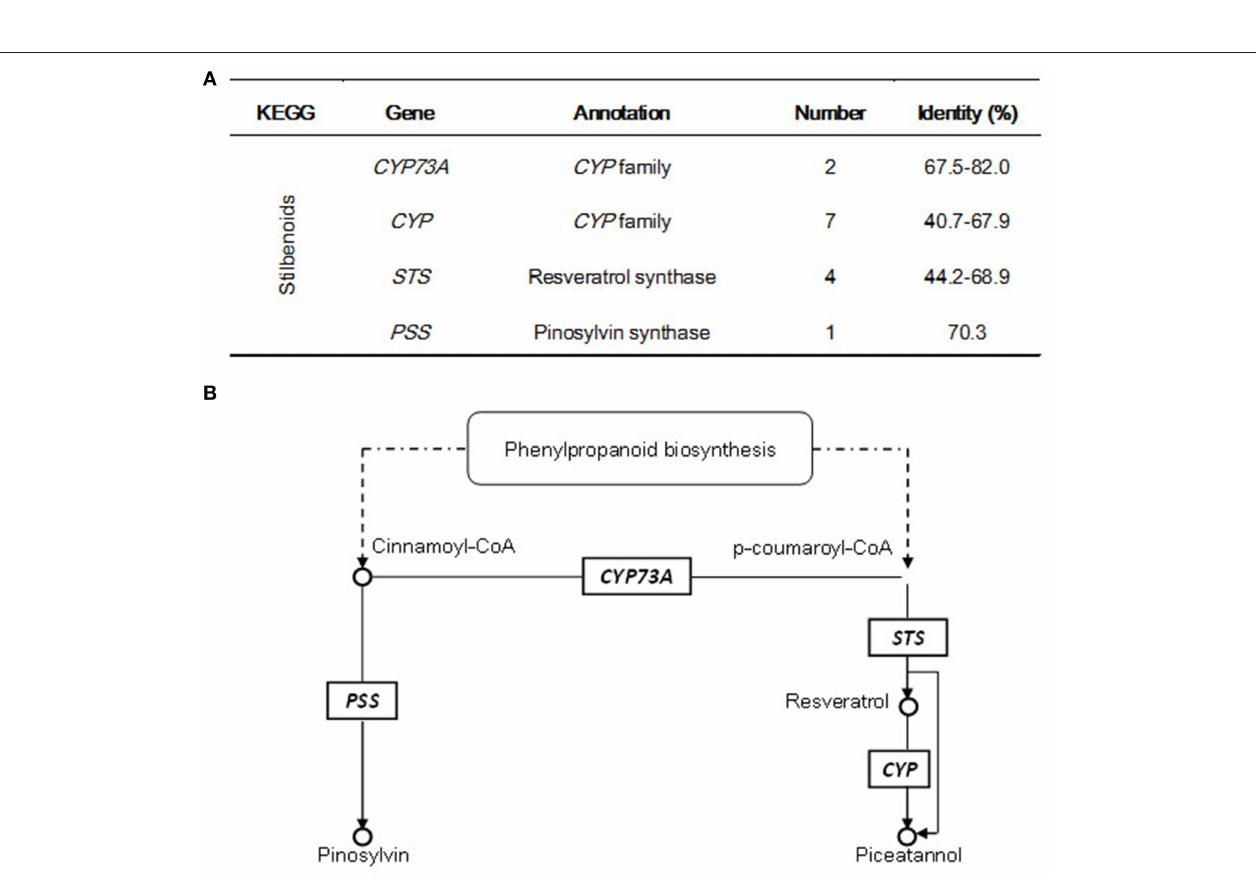
FIGURE 5 | Candidate unigenes involved in stilbenoid biosynthesis in Gnetum parvifolium . (A) Annotatin of candidate genes; (B) Biosynthetic pathway with identified candidate genes; referred from Hammerbacher et al. (2011), and KEGG pathway “Stilbenoid, diarylheptanoid, and gingerol biosynthesis” (http://www.kegg. jp/kegg-bin/show_pathway?ko00945+K00517).